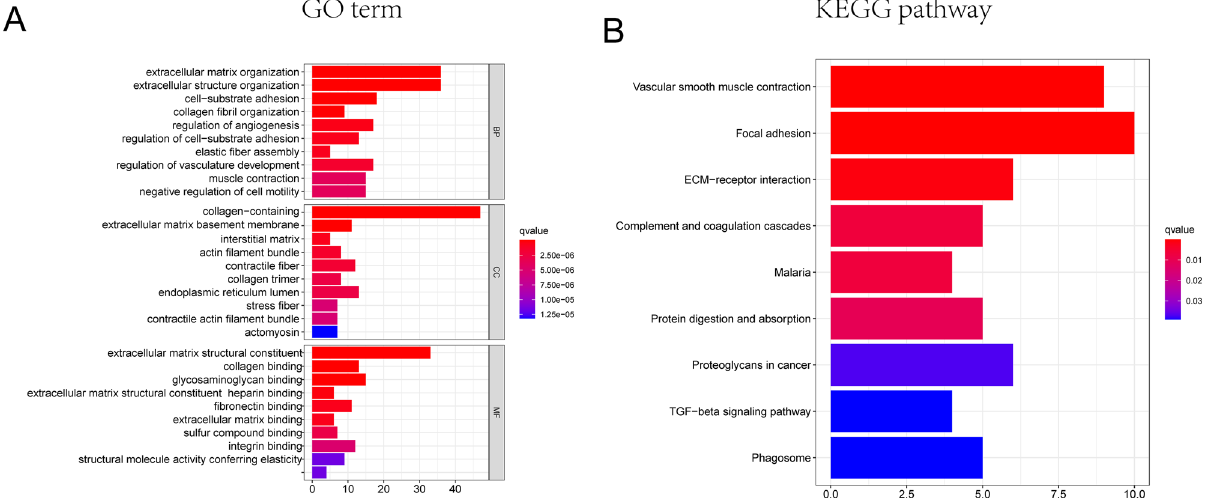
Figure 4. Functional enrichment analysis of the DEGs. ( A ) Top 10 enriched GO terms of the DEGs ( B ) Top 10 enriched KEGG pathways of the DEGs. The box color represents the number of enriched genes. Red represents a large number of genes enriched; blue is the opposite. DEGs differentially expressed genes, BP biological process, CC cellular component, MF molecular function. (all adjusted p <